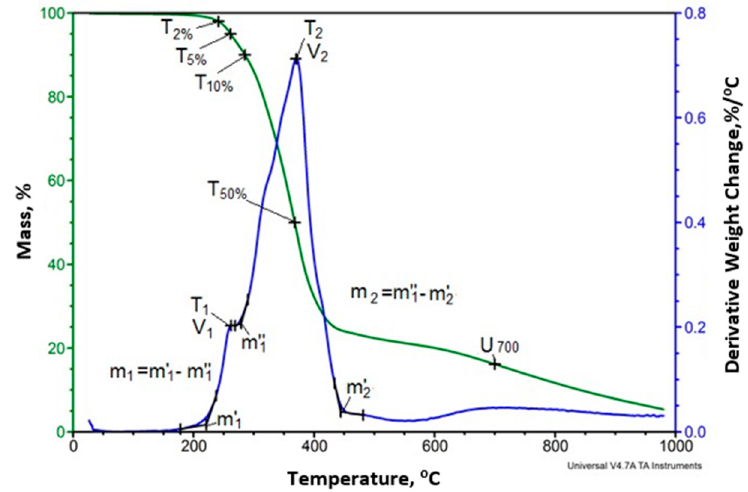
Figure 5. The examples of thermogravimetric analysis (TGA) curves for foam sample R.